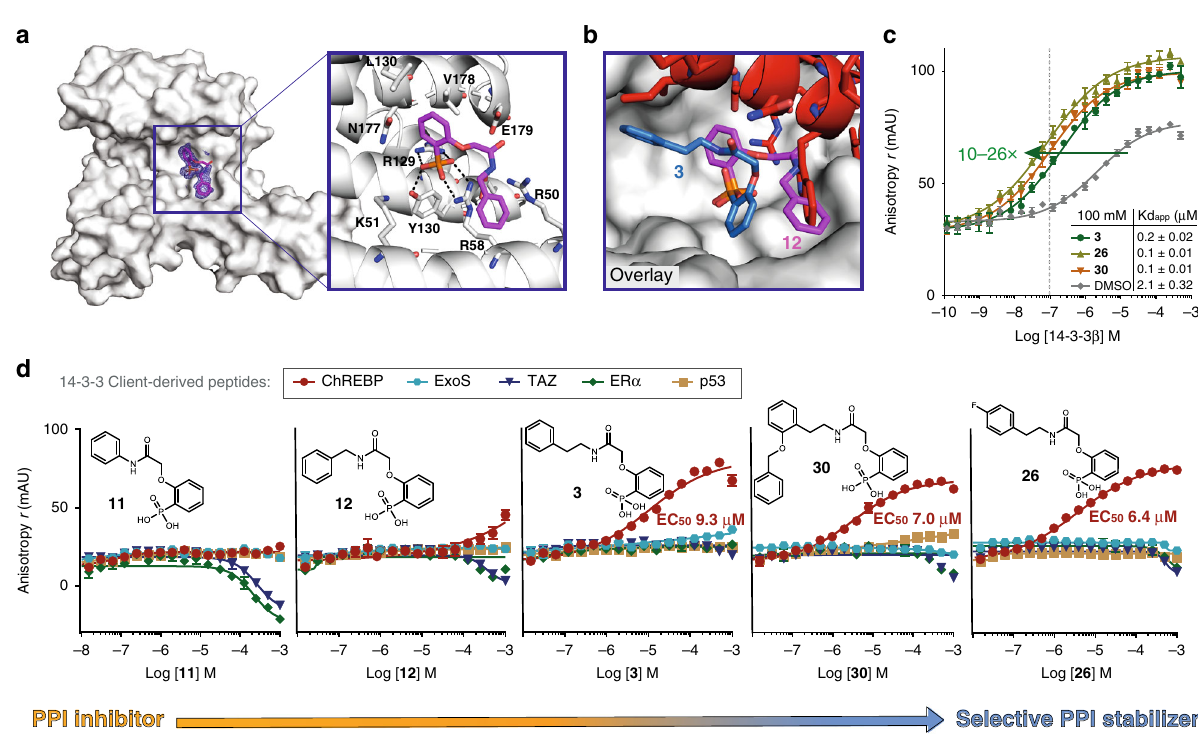
Fig. 4 Rational optimization of compound series enables selective stabilization of the 14-3-3/ChREBP complex. a Co-crystal structure of 14-3-3 and 12 binding in the phospho-accepting pocket. Front view of 14-3-3 monomer (white surface) and 12 (purple sticks). Final 2F o – F c electron density (blue mesh, contoured at 1.0 σ ) displayed for 12 . The panel shows the surrounding amino acid side chains of 14-3-3 (white sticks) and the interactions between 12 and 14-3-3 (black dashed lines). b Crystallographic overlay of 12 (purple sticks) binding to 14-3-3, and 3 (blue sticks) binding to the 14-3-3/ChREBP binary complex. c Binding curves of 100 nM fl uorescently-labeled ChREBP peptide titrated with 14-3-3 β in the presence of 100 μ M ligands ( 3 , 30 , or 26 ). Fold stabilization of the protein – protein interaction binding af fi nity depicted (green arrow). d Molecular switch evolution series, starting from PPI inhibitory activity for 11 and 12 (left) toward selective PPI stabilization for 3 , 30 , and 26 (right), as observed from titration data for 14-3-3 β (2 μ M) and several client- derived peptides (100 nM) each titrated with the compounds. Data and error bars represent mean ± SEM, n = 3 replicates. Source data are provided as a Source data fi